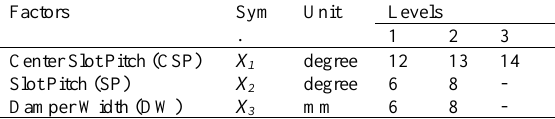
Table 3. Factor levels.